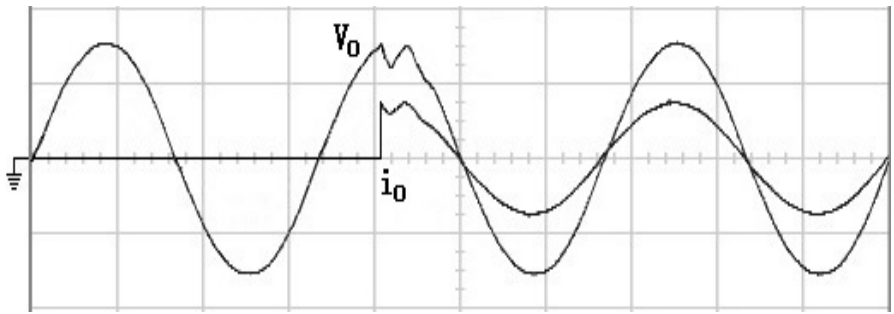
Figure 8. Experimental output waveforms at step-load changing conditions obtained using the conventional SMC (vertical: 100 V/division and 20 A/division, horizontal: 5 ms/division).